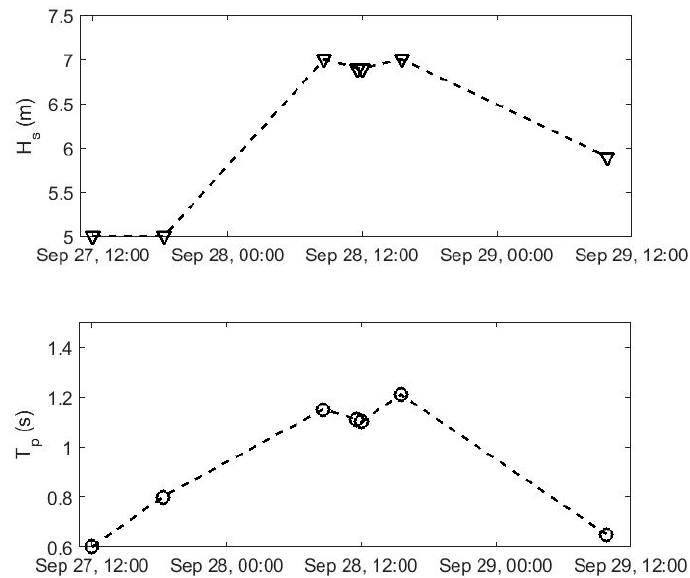
Figure 3. Wave parameters during the experiment period 27–29 September